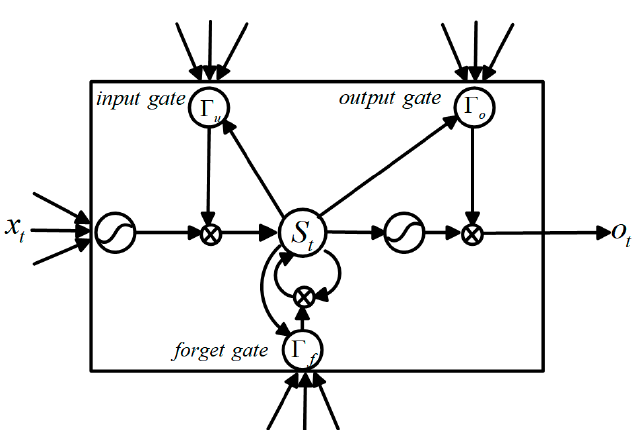
Figure 2. Basic long short-term memory structure.